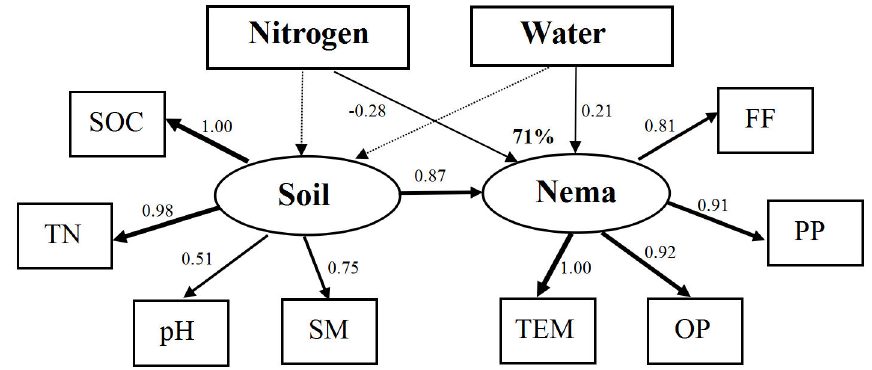
Figure 3. Structural equation models of water addition and N addition effects on soil nematode communities. (χ 2 = 41.08; df = 30; P = 0.09; GFI = 0.79; CFI = 0.96; RMSEA = 0.13). Numbers on arrows are standardized path coefficients. Width of the arrows indicates the strength of the causal influence. Dashed and straight lines represent significant and non-significant pathways, respectively. Nitrogen, N addition effect; Water, water addition effect; Nema, soil nematode communities; Soil, soil properties; SOC, total soil organic carbon; TN, total nitrogen; SM, soil moisture; TEM, total nematodes; FF, the abundance of fungivores; PP, the abundance of plant-parasites; and OP, the abundance of omnivores-predators. doi: